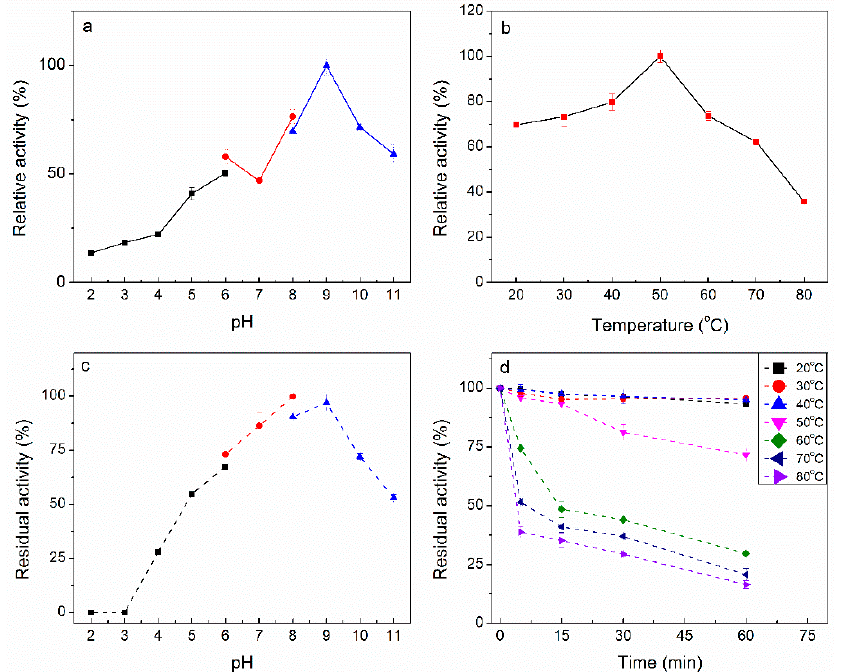
Figure 4. Effect of pH and temperature on activity and stability of PpPel10a. ( a ) Optimal reaction pH, (- (cid:4) -) pH 2.0–6.0, 50 mM sodium acetate buffer; (- -) pH 6.0–8.0, 50 mM phosphate buffer; (- ▲ -) pH (cid:32)